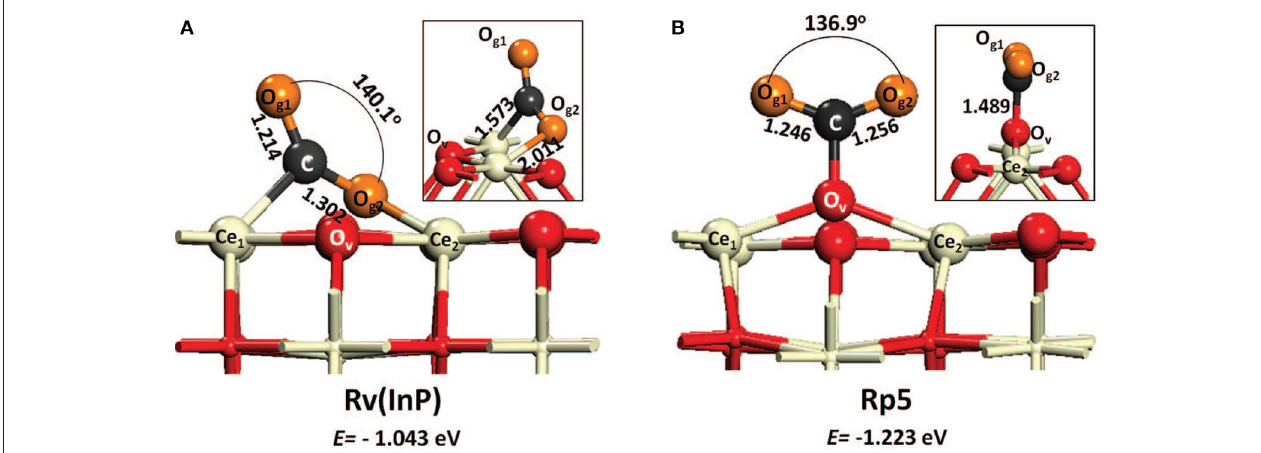
FIGURE 2 | Two CO 2 adsorption configurations on reduced ceria (110) with in-plane (A) vacancy [Rv(InP)] and (B) split vacancy (Rp5). The surface oxygen nearest the vacancy is labeled as O v . Both structural parameters and energies of adsorption are depicted (from Cheng et al., 2013, reproduced with permission of AIP